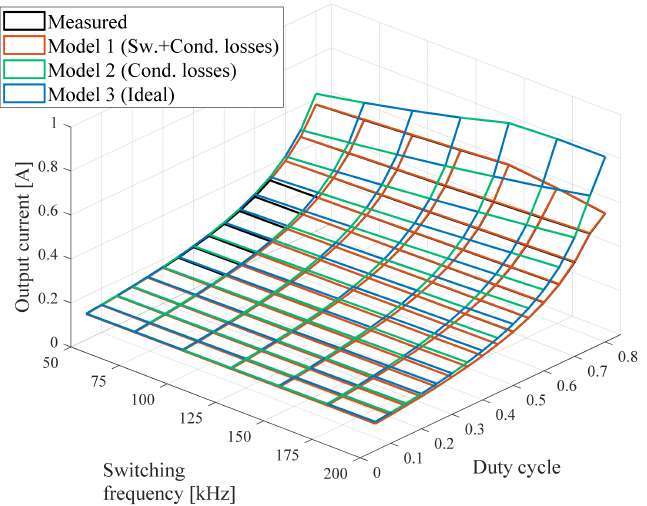
Figure 15. Predicted output current for known input voltage, input current and duty cycle.